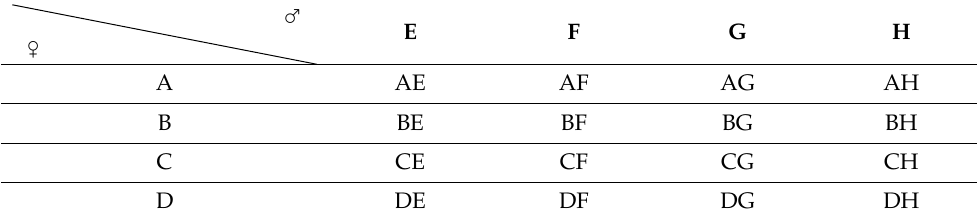
Table 3. The code of inbred lines and hybrids of Chinese